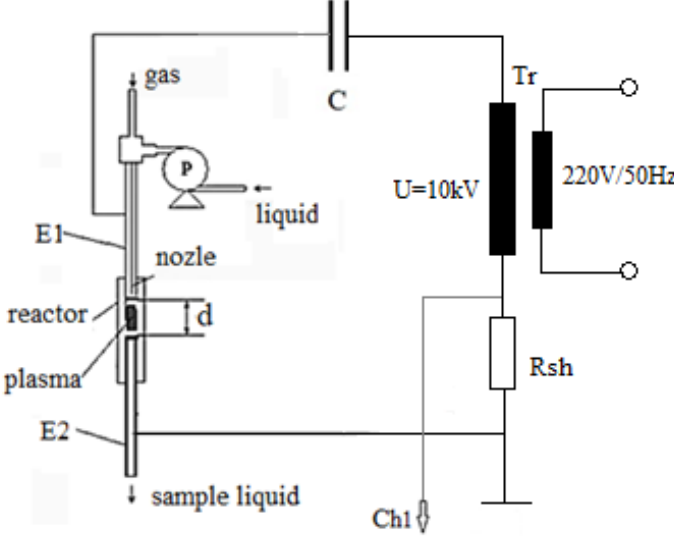
Figure 3. The schematic of capacitive current limitation plasma generator (CCL).